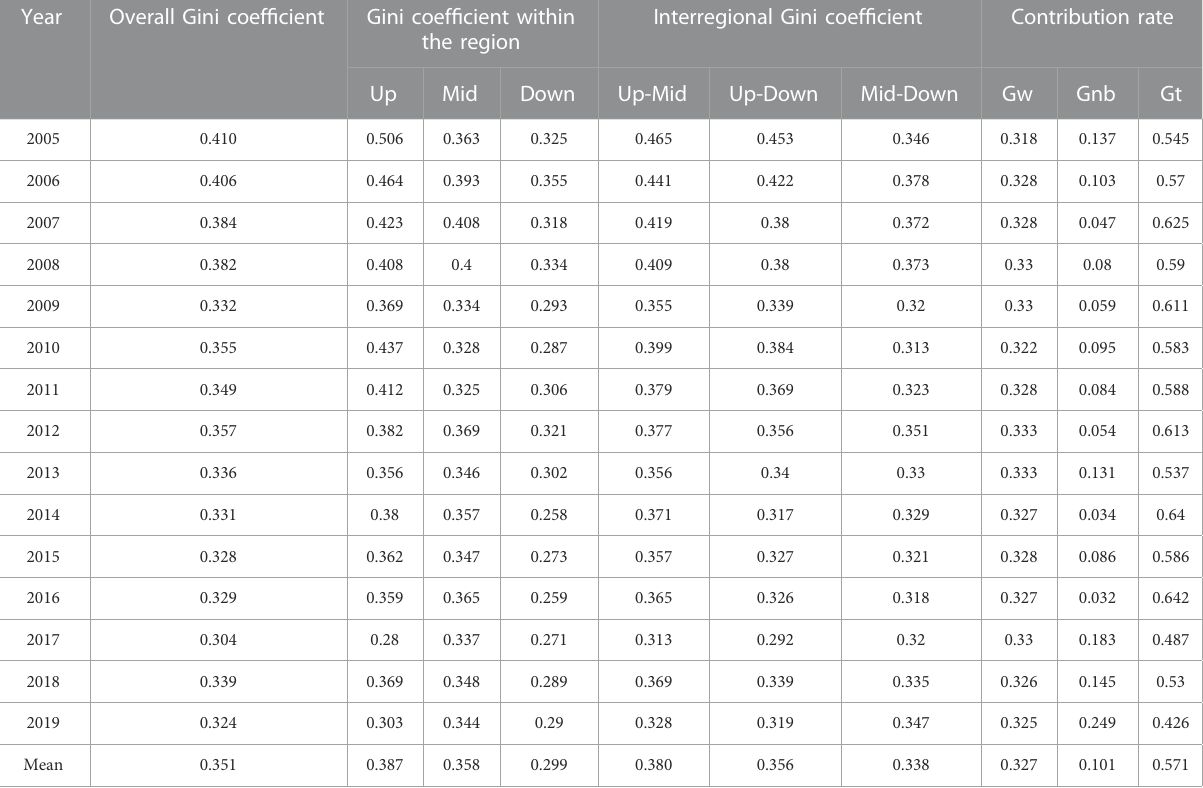
TABLE 3 Disparities in ULGUE in the Yangtze river economic belt